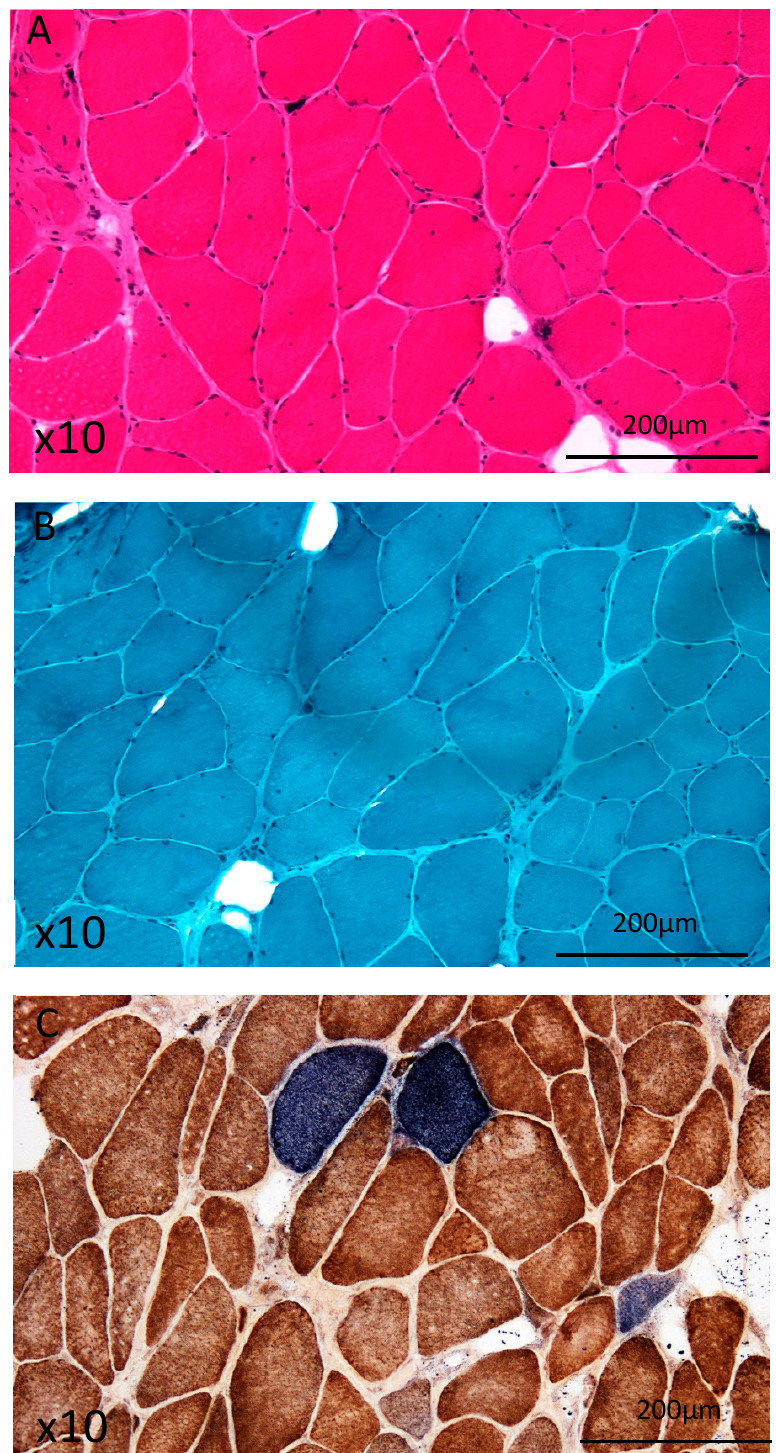
Figure 2. Histochemical findings: ( A ) Hematoxylin and eosin staining, ( B ) Gomori trichrome staining and ( C ) cytochrome c oxidase (COX)-SDH histochemistry revealing numerous COX-deficient (blue reaction product) fibres.